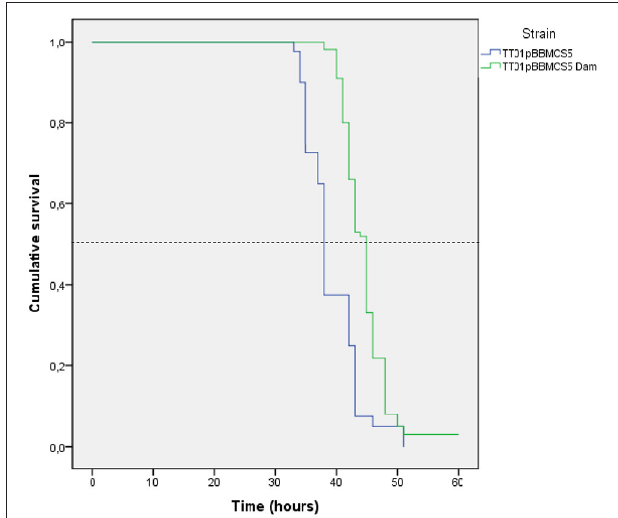
FIGURE 5 | Infection of Spodoptera littoralis larvae by P. luminescens overexpressing dam and the control strain. Proportion of survival of S. littoralis after injection of 10 4 CFU of P. luminescens overexpressing dam (TT01 + pBB-Dam, green) or carrying the vector control (TT01 + pBBR1-MCS5, blue). Graph represents the results from 4 to 5 independent experiments (with 20 insect larvae per experiment). The survival of 50% of the infested larvae is represented by the dotted line. The time needed to kill 50% of infected larvae (LT 50 ) was significantly different between the two strains ( p < 0.001, Wilcoxon test).